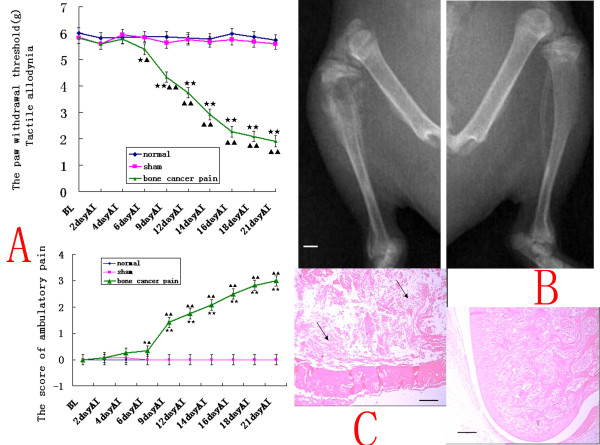
A rat model of bone pain from metastatic bone cancer. (A) Rats with tibia tumors after Walker 256 cells inoculation displayed both tactile allodynia and spontaneous pain. The PWL progressively decreased and the ambulatory score progressively increased on days 6 (n = 12, ANOVA2w, P < 0.05 pos-hoc Bonferroni, df = 2, F = 1.07), 9, 12, 14, 16, 18, and 21 (ANOVA2w, P < 0.01, df = 2, F = 1.13) after inoculation (AI) in the tumor-bearing group compared with sham-injected controls and normal rats. Results are given as means ± S.D, *p < 0.05 **P < 0.01 vs. normal group; ▲p < 0.05 ▲ ▲p < 0.01 vs. sham group. (B) Radiographs of the left tibiae 18 days after inoculation with Walker 256 cells and the right normal tibiae. There was bilateral cortical bone damage and large bone defects at the 18 days' tumor-bearing proximal epiphysis of the tibiae.(C) HE staining of normal (upper panel) and 18 days of tumor-bearing (lower) proximal epiphysis of the tibiae. Note that tumor cells were densely packed in the marrow cavity and induced the destruction of trabeculae. Arrows indicate tumor cells. Bar = 1 mm in B and 40 μm in C.